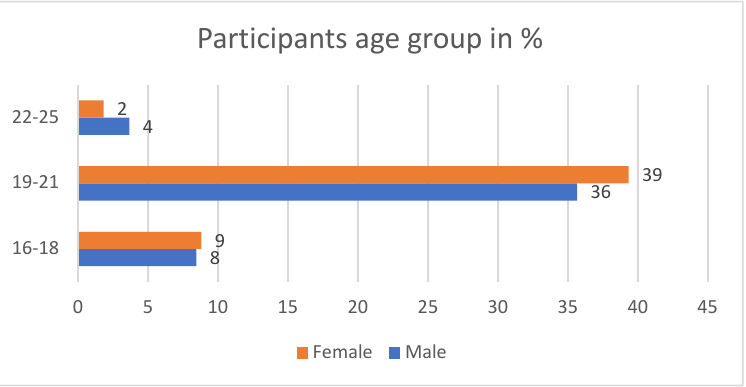
Figure 2. Sex-wise participants’ age groups.